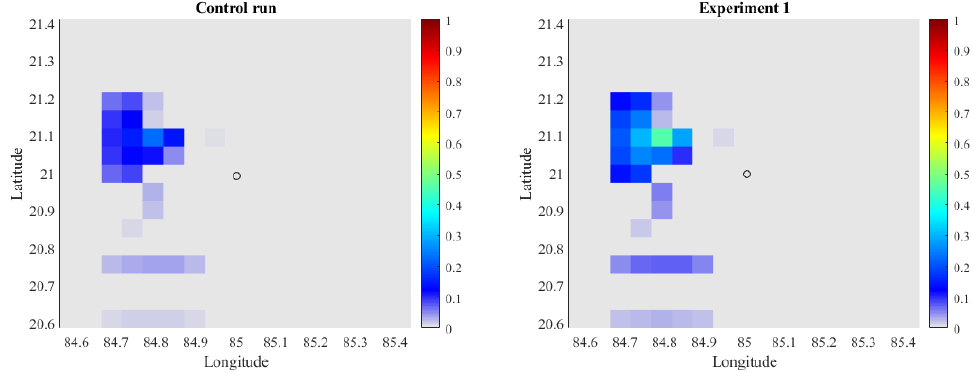
Figure 11. Median diameter comparisons on 22 March 2008 for WDM6 at near-surface level .